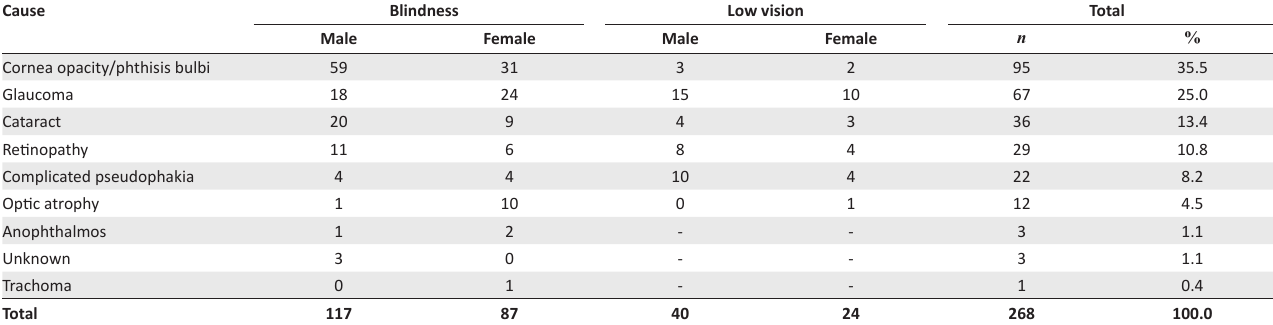
TABLE 4: Causes of low vision and blindness in the better eye. Cause